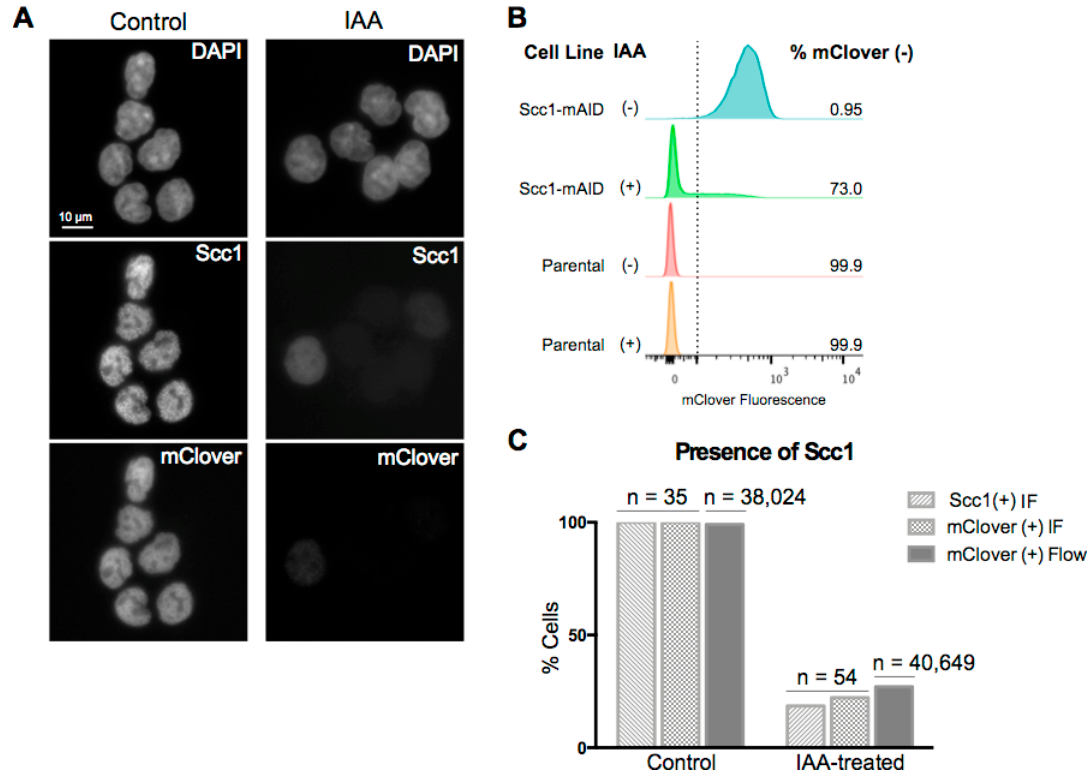
Figure 1. Auxin treatment results in loss of Scc1. ( A ) Immunofluorescence (IF) for Scc1 and mClover in HCT116 Scc1-mAID-mClover cells under control conditions or two hours of auxin treatment. ( B ) Flow cytometry analysis for mClover fluorescence using both HCT116 Scc1-mAID-mClover cell line and parental HCT116 cell line as a negative control. The mClover-positive gate was set based on the parental cell line at 10 2 fluorescence units. ( C ) Comparison of the direct IF read-out of loss of Scc1 and indirect read out of loss of mClover through both flow cytometry and IF.